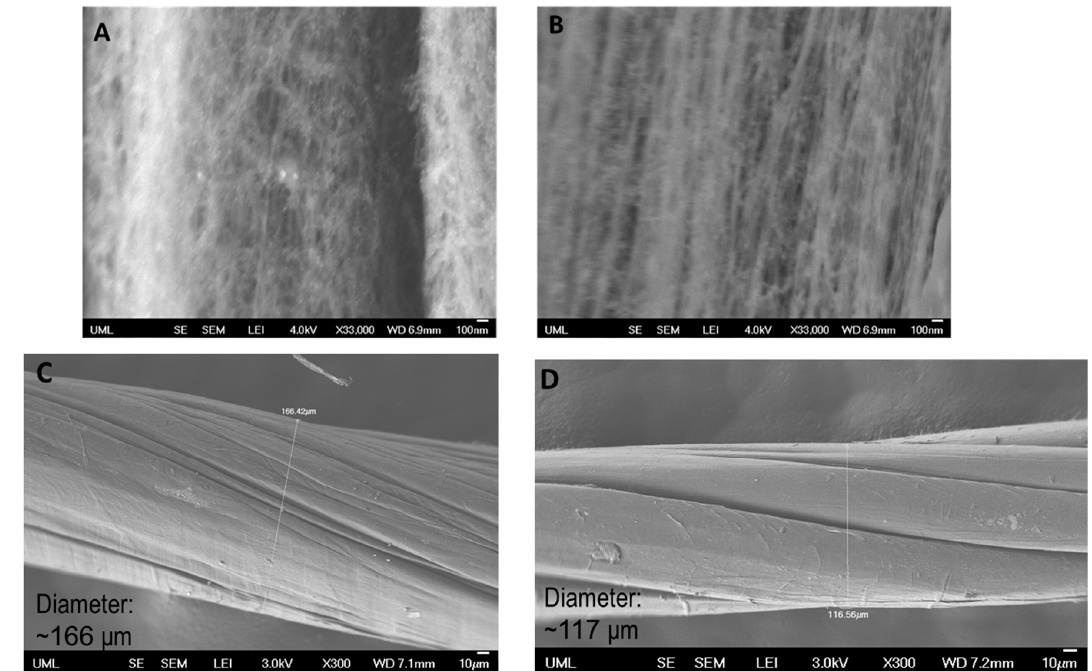
Figure 8. Untreated CNTYs (stretching direction) after 100 cycles to a 5% strain ( A ) and a 12% strain ( B ). Untreated CNTYs diameter (perpendicular to the stretching direction) before ( C ) and after cyclic tension to 12% strain ( D ).